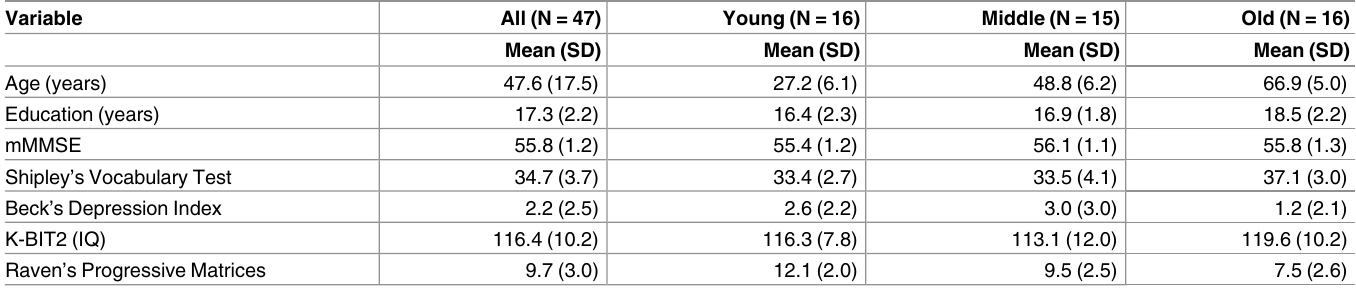
Table 1. Demographic characteristics of the